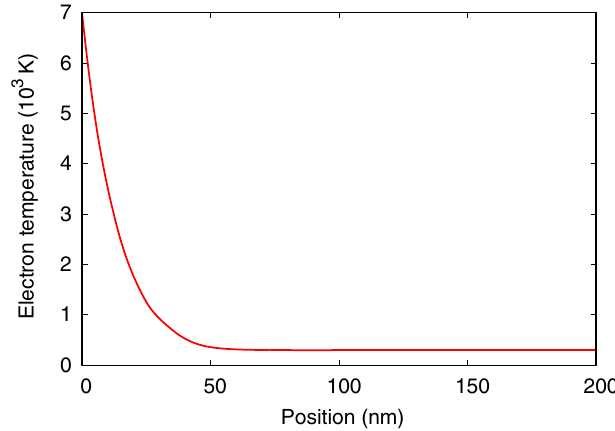
FIG. 12. Electron-temperature distribution in bulk aluminum as a function of the position from the